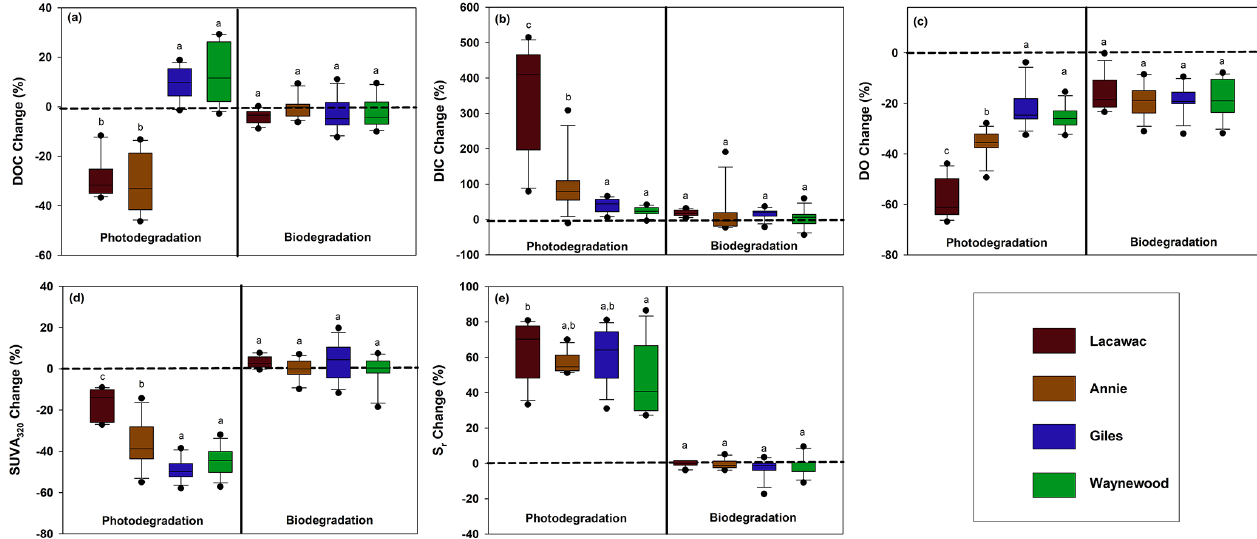
Figure 1. The monthly average percent change from the dark and killed control treatments (dashed line) in each lake for photodegradation (left) and biodegradation (right) for (a) DOC, (b) DIC, (c) DO, (d) SUVA 320 , and (e) S r . Statistical differences ( p< 0 . 05) between the lakes are indicated by different letters above each box plot. For each box plot, n = 12 replicates.